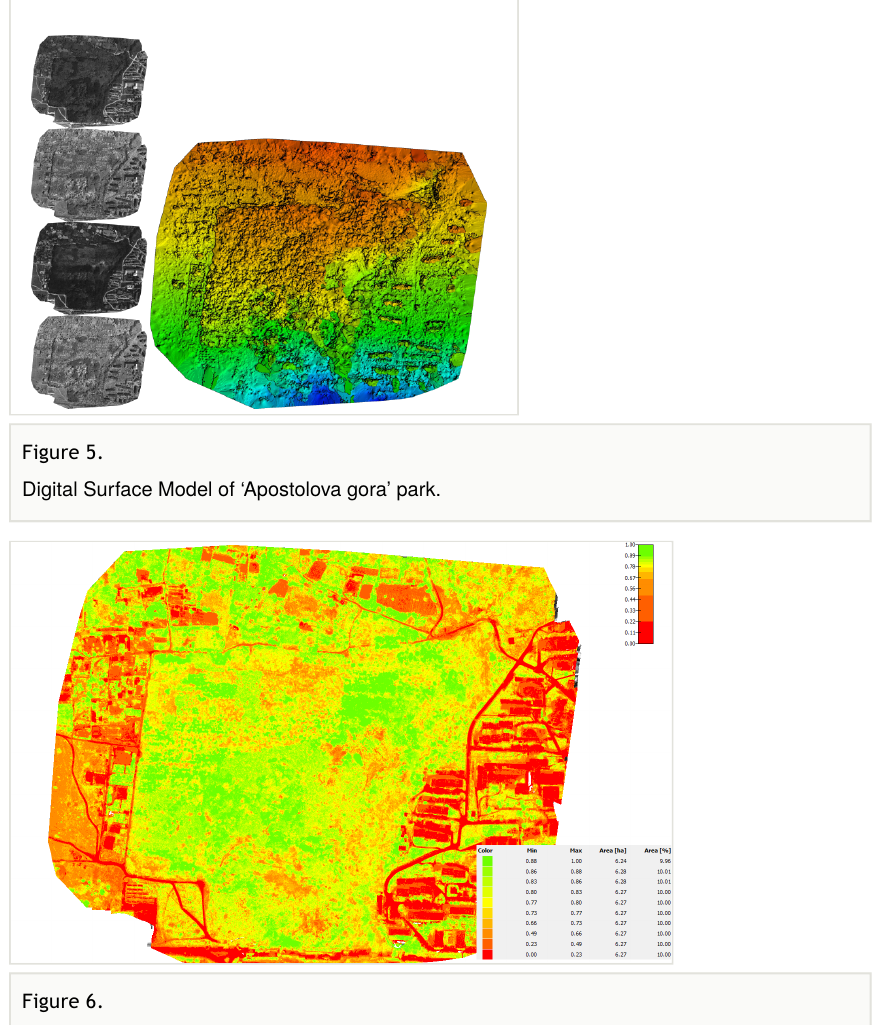
The map clearly shows the areas with a high value of vitality of vegetation cover, as well as those with a lack of vegetation cover and vegetation in an unsatisfactory condition. In almost 50% of the studied area, the vegetation index is more than 0.75, but in the park territory, relatively large areas can be seen with poor vegetation and the corresponding NDVI index values lie between 0.6 and 0.7. The territory of the central part of the city has been captured with 1004 individual images, covering 61.2 ha with an average resolution of 13.2 cm. A view of the 4 captured channels